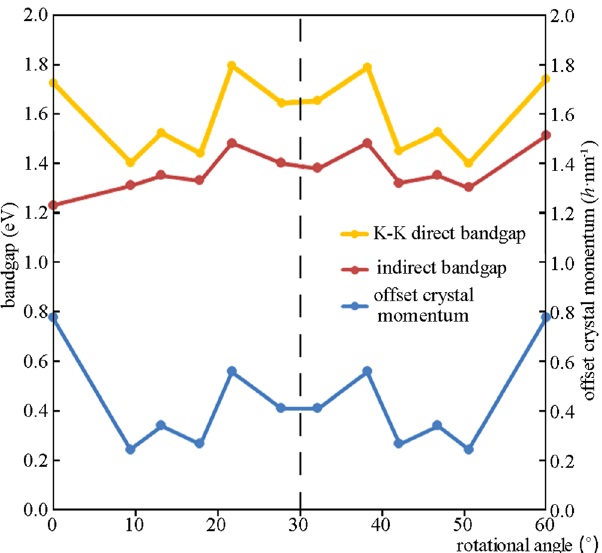
Figure 5. Dependences of the K-K direct bandgap values, the indirect bandgap values and the offset crystal momentums of bilayer MoS 2 with and without RSFs on the rotational angles. These data are from the calculated electronic structures in Fig. 4c,d and Supplementary Fig.